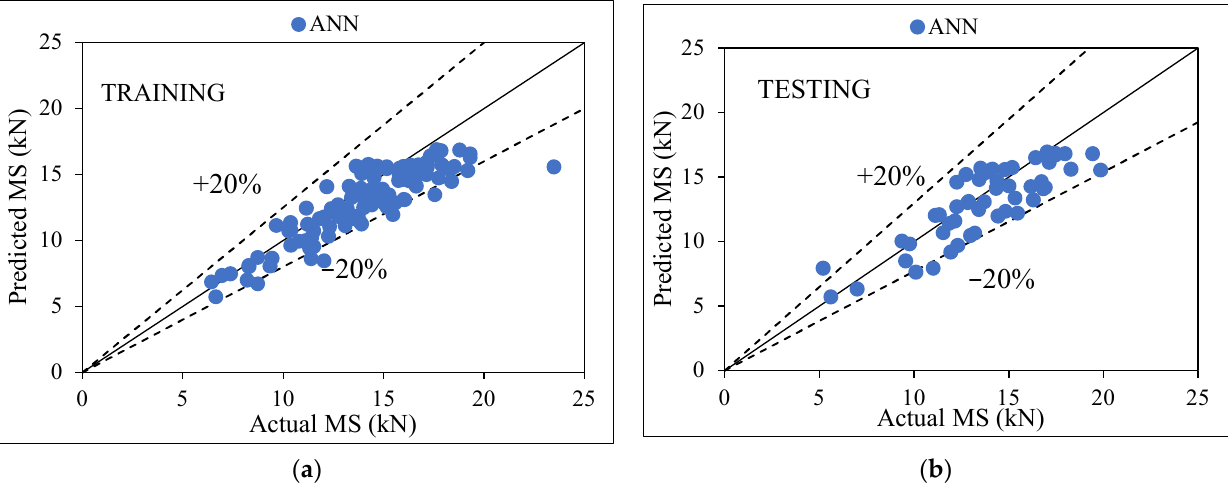
Figure 5. ( a , b ). Agreement graph showing actual vs. predicted values of MS using an ANN-based model for both stages.